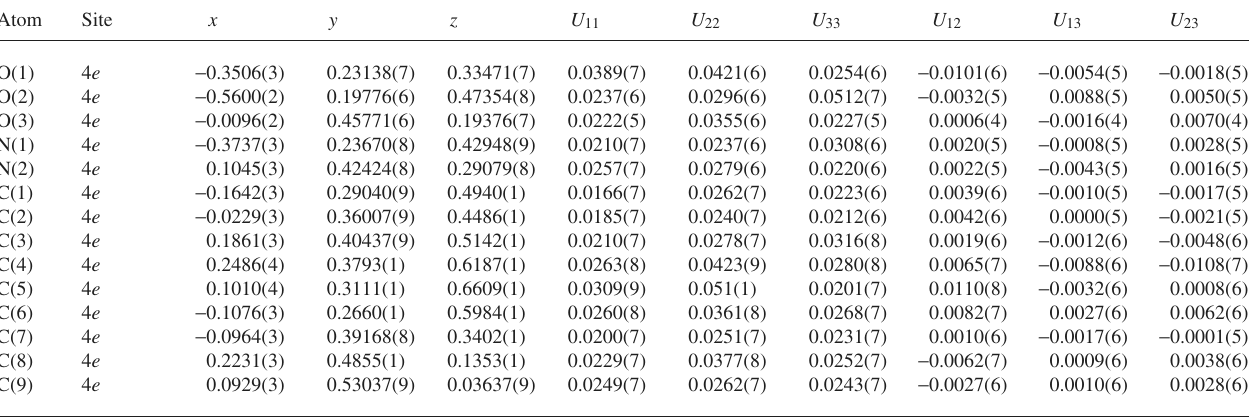
Table 3. Atomic coordinates and displacement parameters (in Å 2 )